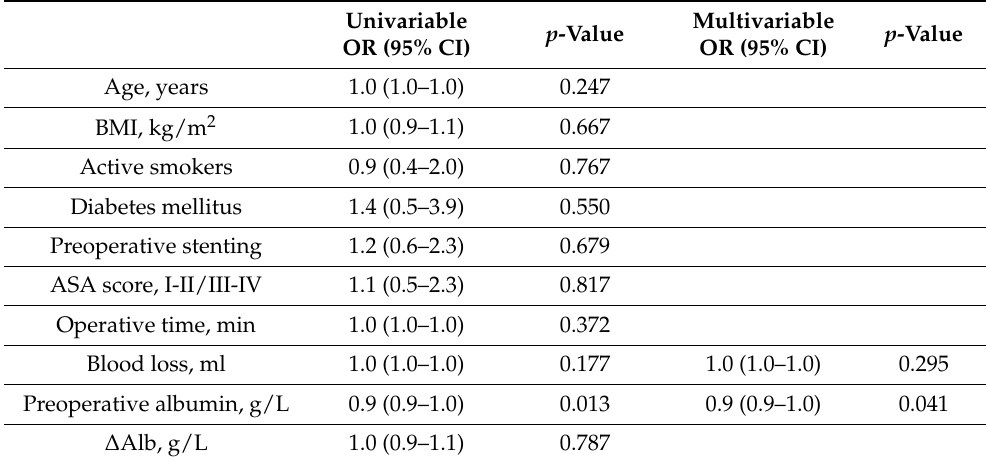
Table 2. Uni- and multivariable logistic regression for factors predictive of postoperative complica- tions after